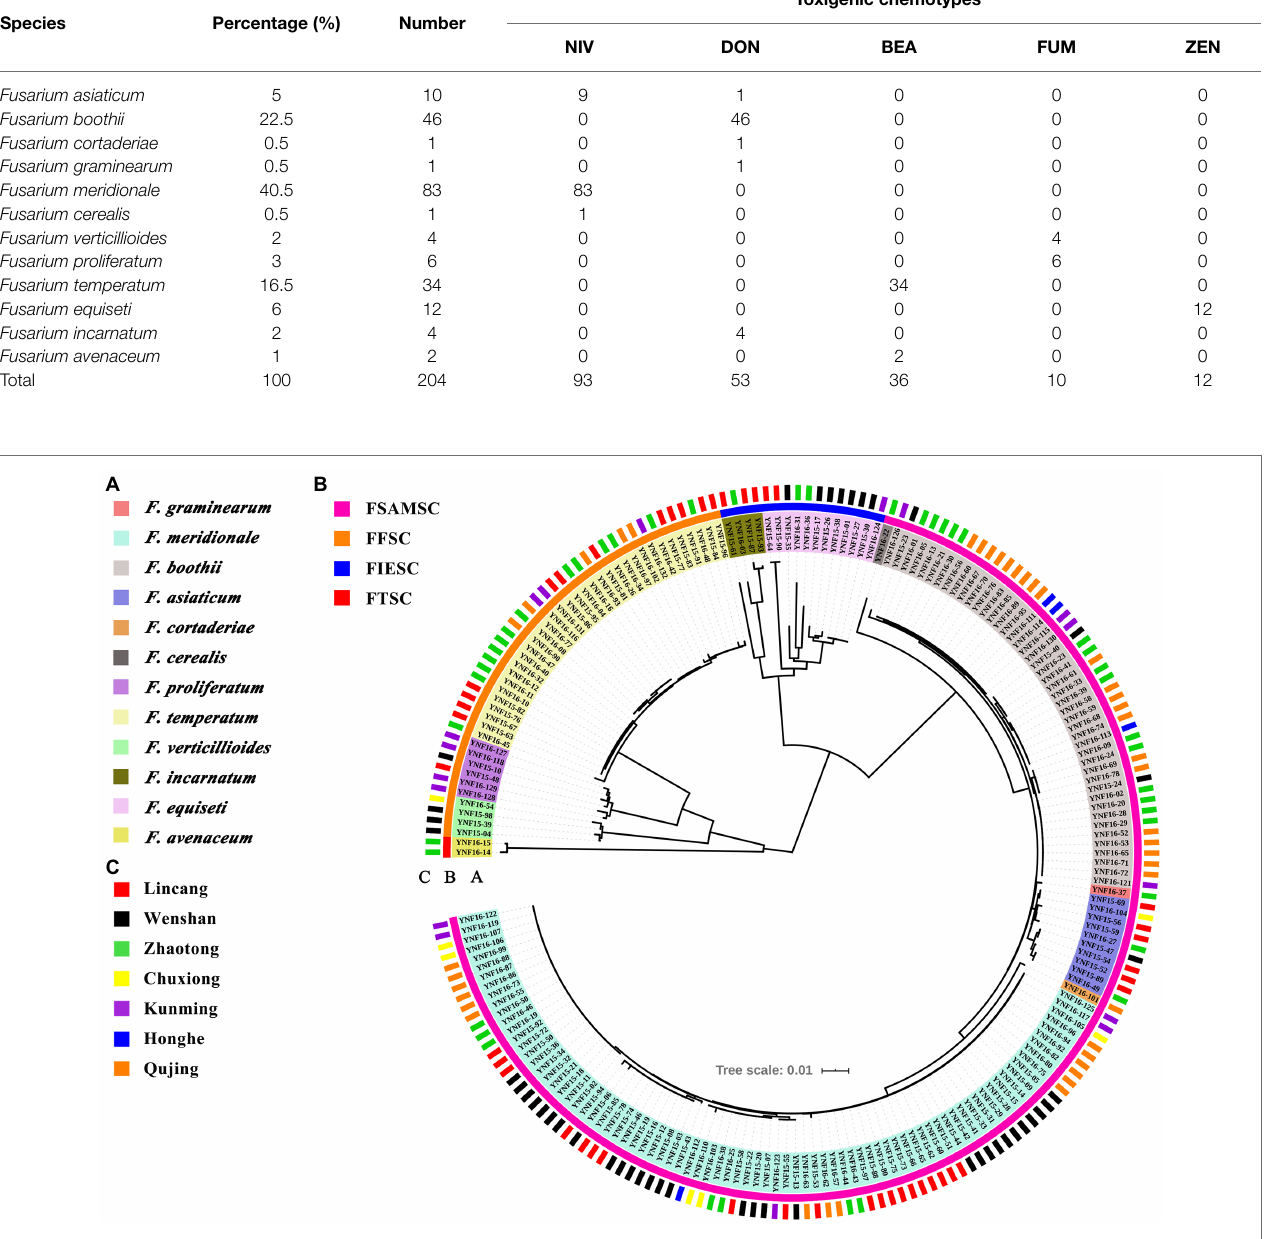
FIGURE 4 | Phylogenetic analysis of Fusarium species associated with maize stalk rot disease in Yunnan Province of China. The tree was constructed by the neighbor-joining method based on partial translation elongation factor 1 α ( TEF-1 α ) sequences. Clade support was inferred from 1,000 bootstrap replicates. The Interactive Tree of Life (see footnote 3) was used to beautify the phylogenetic tree. (A) Species information about each Fusarium isolates identified in this study and their corresponding color information. (B) The abbreviation of Fusarium species complexes. FSAMSC means Fusarium sambucinum species complex. FFSC means Fusarium fujikuroi species complex. FIESC means Fusarium incarnatum - equiseti species complex. FTSC means Fusarium tricinctum species complex. (C) The geographical location of each Fusarium isolates identified in this